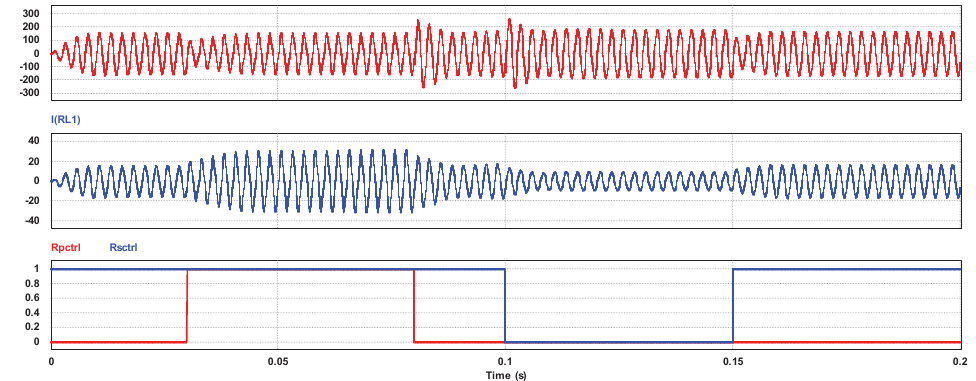
Figure 11. Simulation results for half and double load